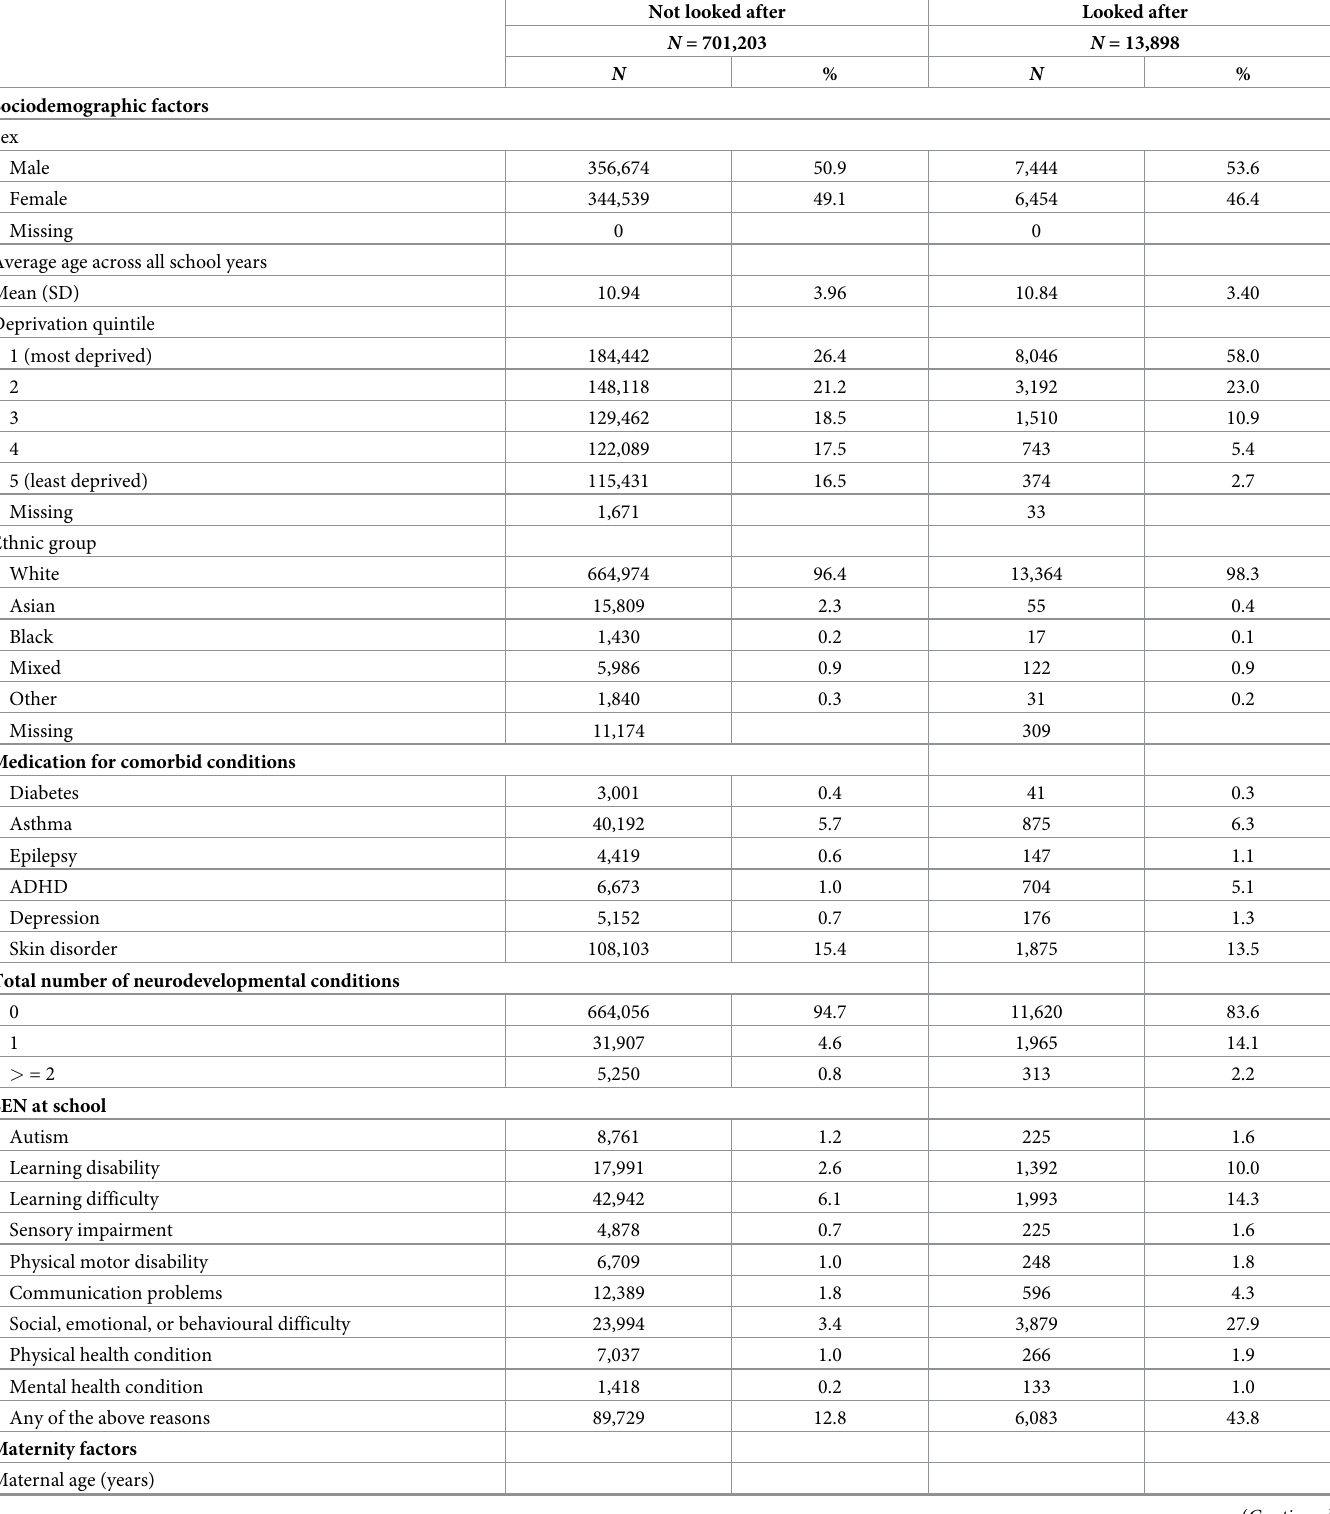
Table 1. Characteristics of looked after schoolchildren compared with their peers.